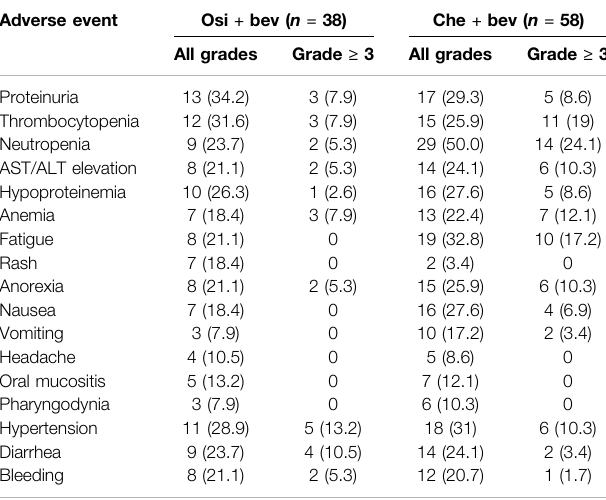
TABLE 3 | Summary of adverse events. Values are expressed as frequencies [n